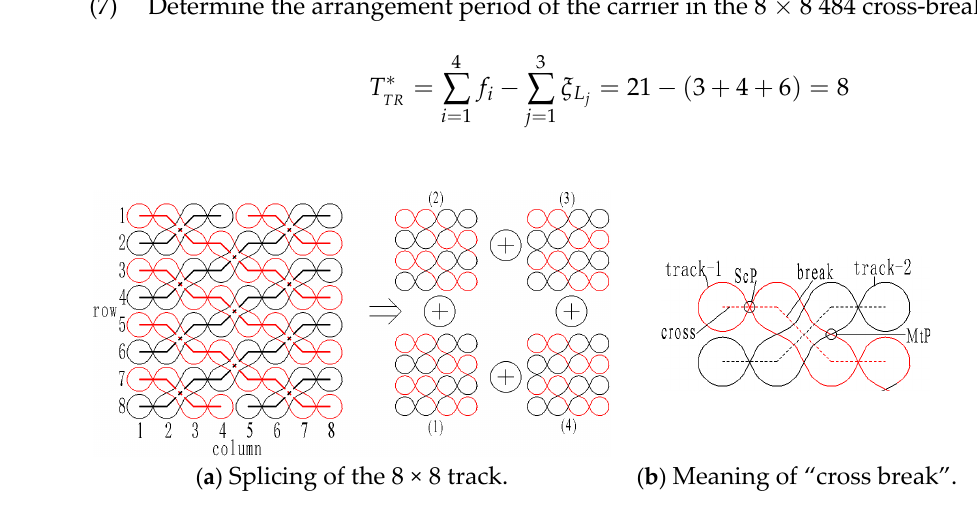
Figure 3. Schematic of 8 × 8 484 cross ‐ break track.